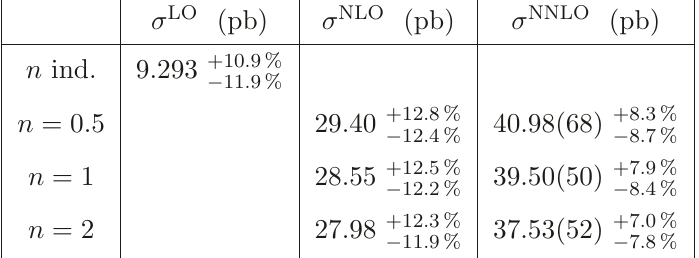
Table 2 . Results for LO, NLO and NNLO total cross sections with the photon kinematical cuts described in the text (beginning of section 3). The results are obtained by using smooth isolation and n denotes the power in the isolation function of eq. (2.3). The central values of σ are obtained with the scale choice µ R = µ F = µ 0 = M Tγγ , and the scale dependence corresponds to independent variations of µ R and µ F between µ 0 / 2 and 2 µ 0 . The last digit of the LO and NLO cross section values has an error of one unit from the statistical uncertainty of the numerical calculation. The systematical error on σ NNLO is explicitly given in round